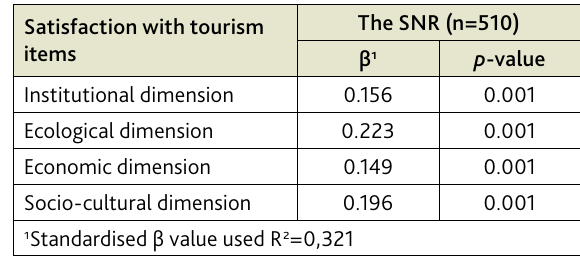
Table 4. Regression analysis of the SNR on residents